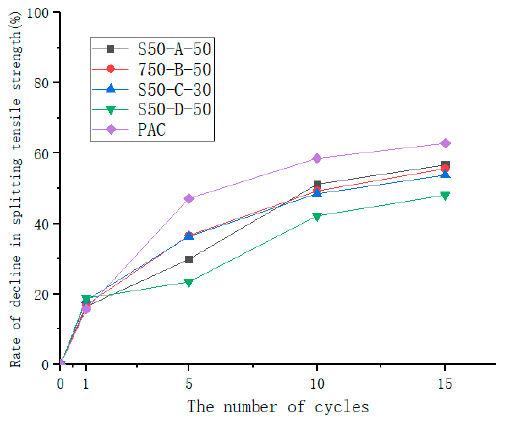
Figure 11. Rate of decline in splitting tensile strength after freeze-thaw cycle.